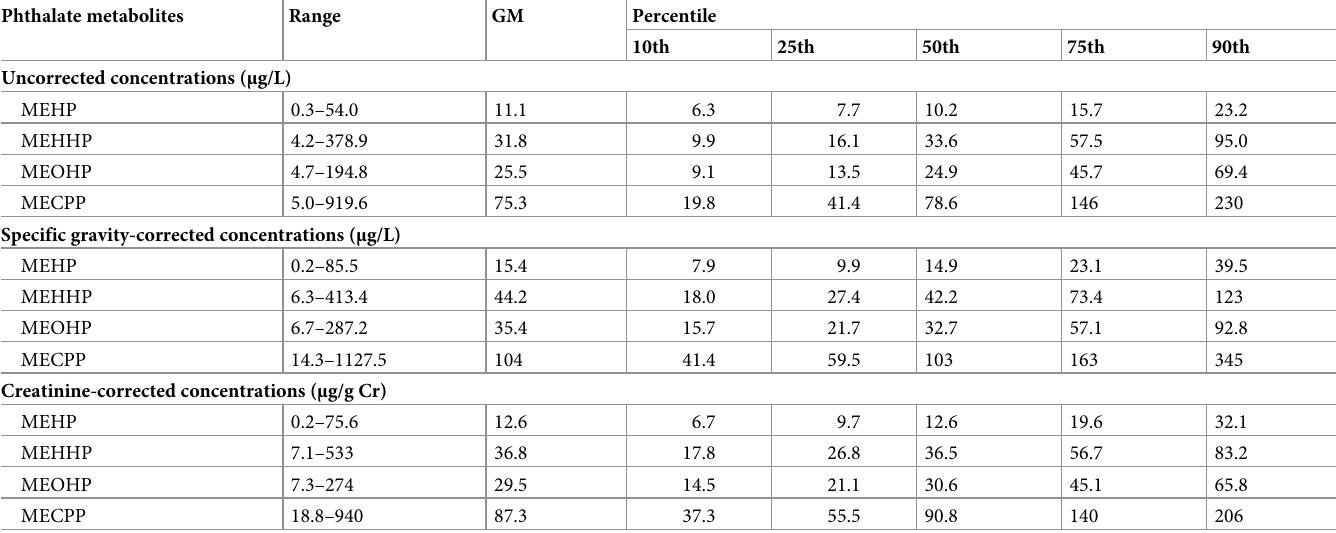
Table 2. Geometric means (GM) and selective percentiles of urinary phthalate metabolite concentrations. Phthalate metabolites Range